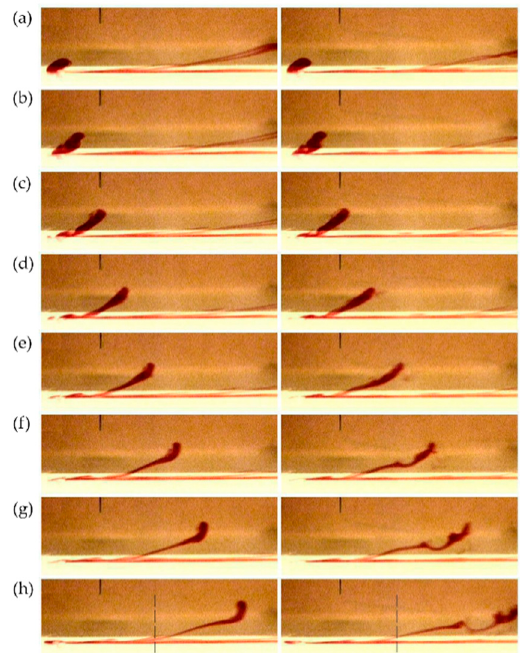
Figure 7. Time series of the flow visualization of the no-control case (left column) and that with control (right column) at x = 4.4 δ indicated in ( h ), with the dotted line indicating the position of the hot-film sensor for scanning the YZ plane. ( a ) vortex ring created on the left corner; ( b – d ) hairpin vortex development reaching to boundary edge; ( e – h ) streamwise stretching process of legs.